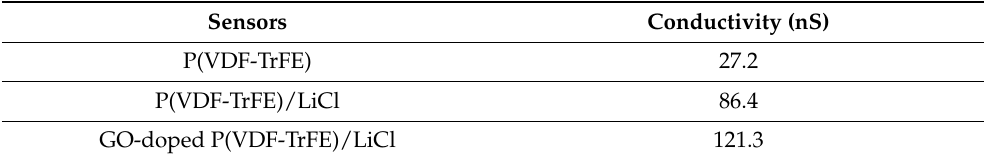
Table 1. Conductivity of P(VDF-TrFE)-, P(VDF-TrFE)/LiCl-, and GO-doped P(VDF-TrFE)/LiCl-based humidity